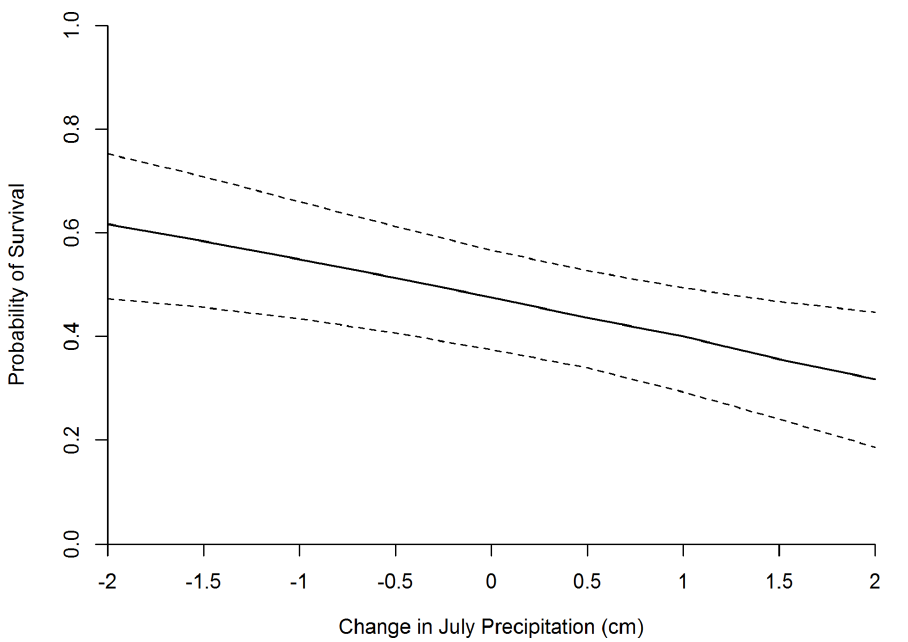
Figure 4. Effects of July precipitation on the probability of greater sage-grouse chick survival to 42 days of age. Dashed lines indicate 95% confidence intervals. A change of 0.0 is equal to the mean July precipitation observed during the extent of this study.